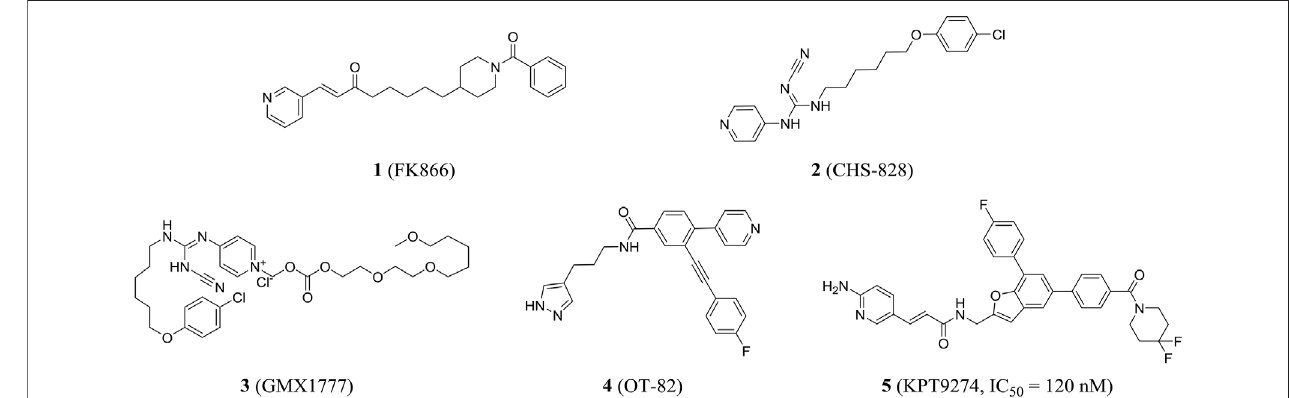
FIGURE 3 | NAMPT inhibitors in clinical trials.